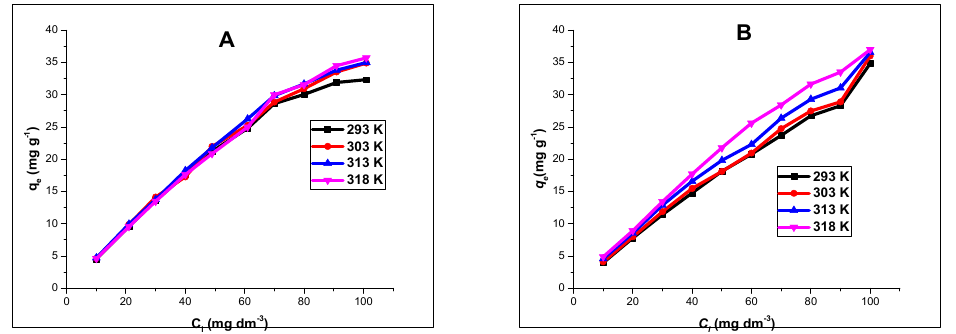
Figure 5. Effect of temperature for ( A ) Zn(II) and ( B ) As(III) uptake from aqueous solutions by MNP-Maph at pH 6.7 and 6.0 respectively (conditions: 4 h contact time, adsorbent dose: 40 mg, adsorbate amount: 20 mL and 200 rpm agitation speed).